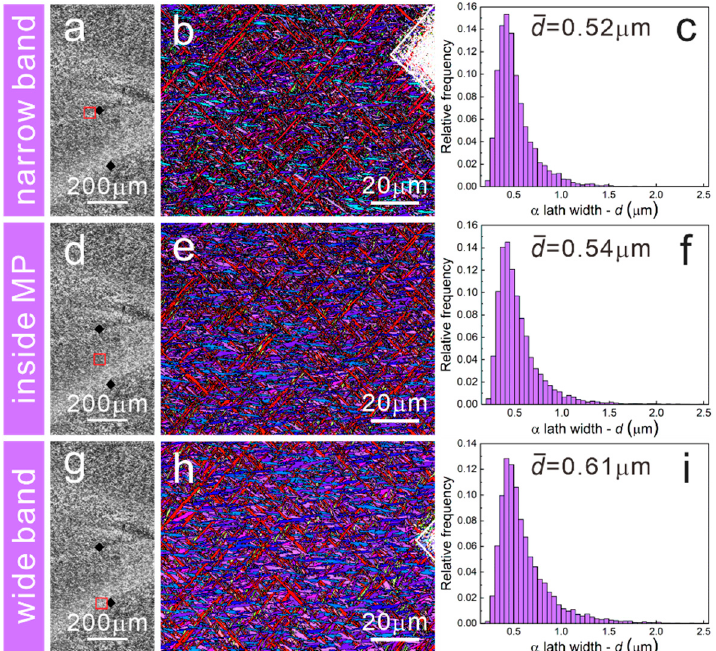
Figure 3. OM images and corresponding inverse pole figures (IPFs) of the EPT0 sample: ( a – c ) wide band, ( d – f ) narrow band, ( g – i ) inside the MP. (The black diamonds are the marking indentations of wide band and narrow band, and the red square is the EBSD scanning region.)